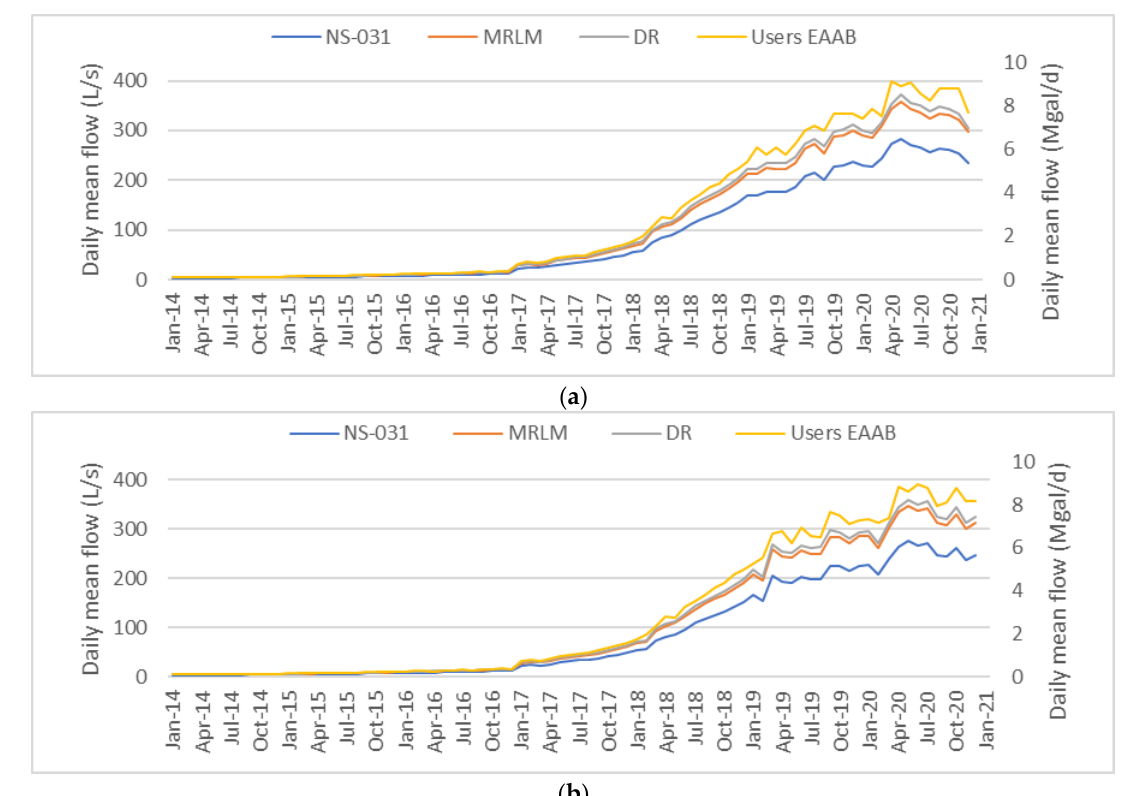
Figure 10. Total daily mean flow for localities being studied ( a ) Mathematical approach; ( b ) Statistical approach.